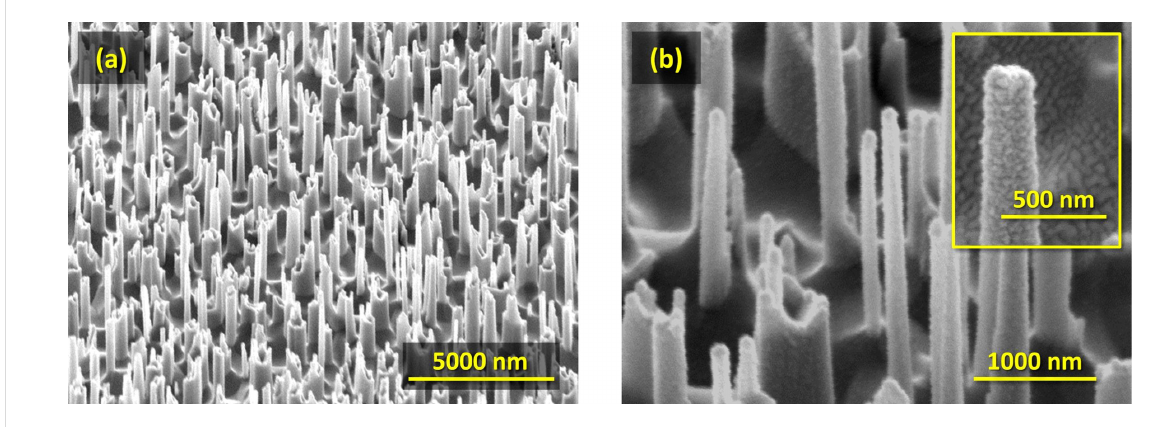
Figure 1: Scanning electron microscopy pictures of (a) bare and (b) coated nanowires on the c-Si substrate. In the inset of (b), the enlargement of a single c-Si nanowire wrapped with supporting layers is depicted, showing excellent coating uniformity.